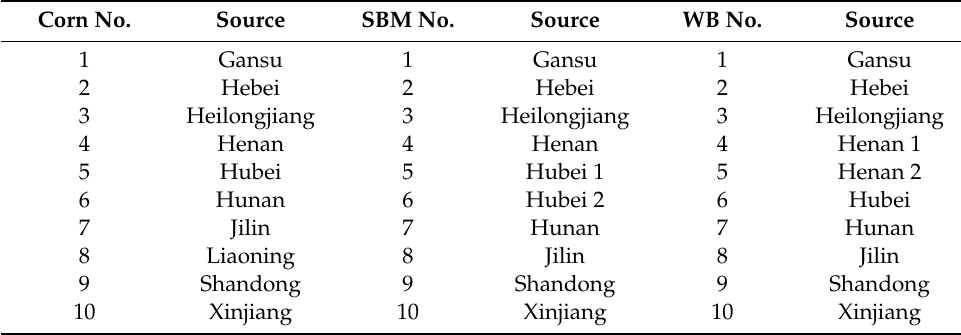
Table 1. Origin of corn, soybean meal (SBM), and wheat bran (WB) used in the study. Corn No.